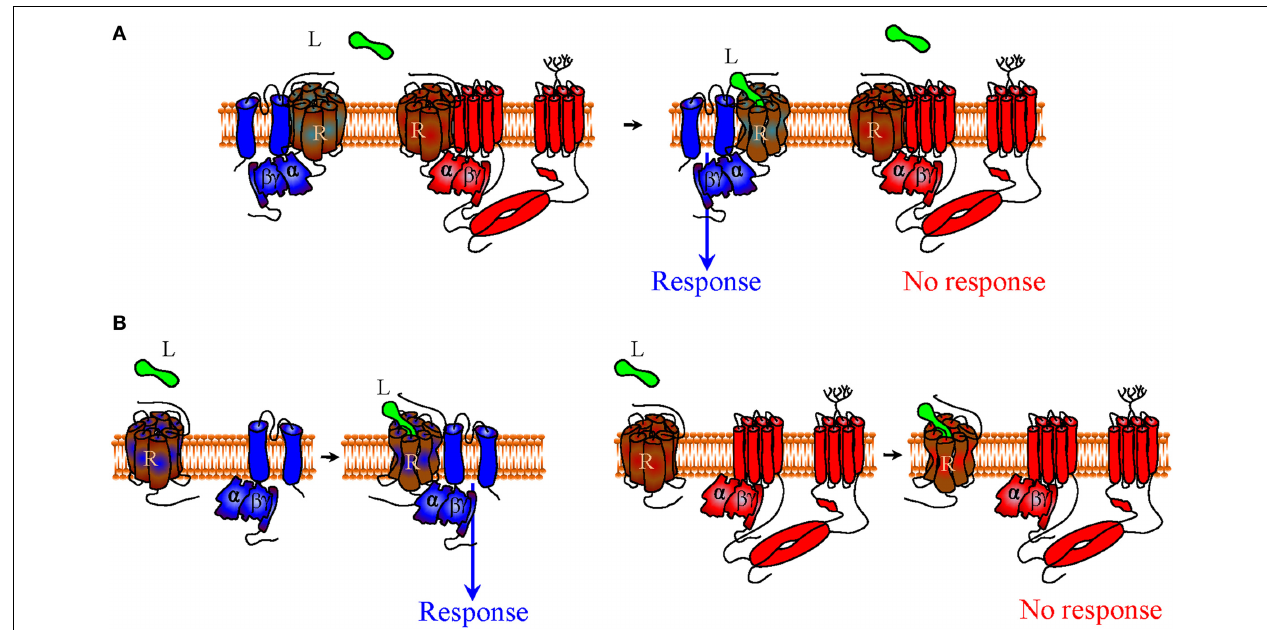
FIGURE 2 | Functional selectivity due to biased signaling of orthosteric receptor agonists. Within the context of a precoupling model, an agonist that preferentially recognizes the receptor conformation stabilized by signaling partners in the channel complex over the receptor state stabilized within the cyclasecomplexwoulddisplaybiastowardchannelsignaling (A) .Inarestricted